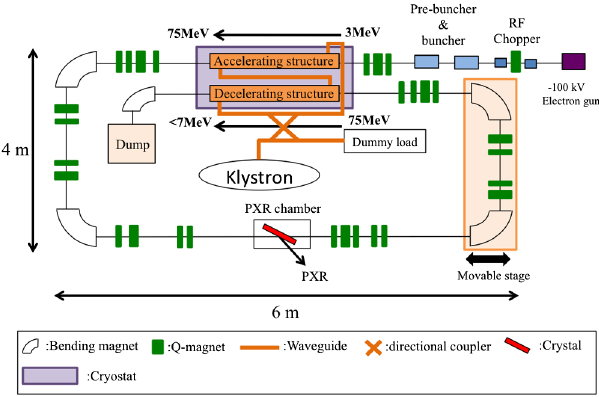
FIG. 1. Layout of PXR source based on linear